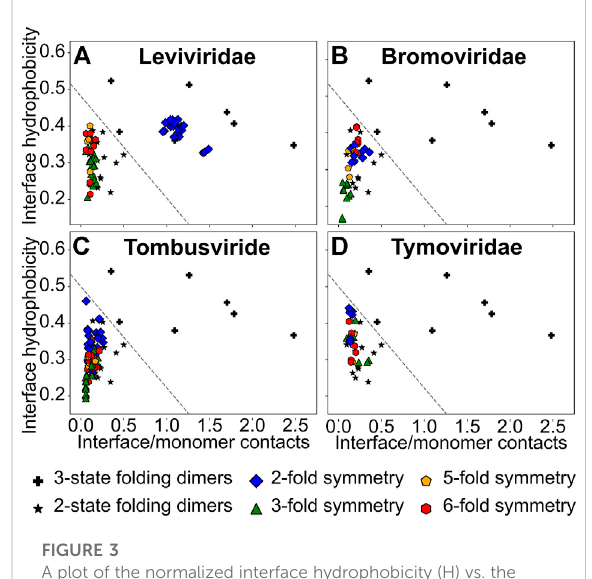
A plot of the normalized interface hydrophobicity (H) vs. the ratioofinterfacecontactstomonomercontacts(R). (A) Leviviridae , (B) Bromoviridae , (C) Tombusviridae and (D) Tymoviridae. A three- state folding dimer ( + ) folds to an intermediate ensemble (either two monomers or a partially folded dimer) from two unfolded monomers before folding to the fi nal dimeric state. A two-state folding dimer (+) folds directly to the dimeric state from two unfolded monomers. These datasets of homodimers are from a previous study on homodimer interfaces (Levy et al., 2004b) and are shown in all panels. An arbitrary line (y/0.5 + x/1.8 = 1), separating the two-state and the three-state dimers, is drawn to provide visual guidance (and does not represent an actual boundary between the two regions). The interfaces between two CPs related through the (quasi-)two-fold rotation symmetry (dimerization interface in CP2; blue diamonds), the quasi-three- fold rotation symmetry (trimerization interface; green triangles), the fi ve-fold rotation symmetry (pentamerization interface; orange pentagons) and the quasi-six-fold rotation symmetry (hexamerization interface; red hexagons) are